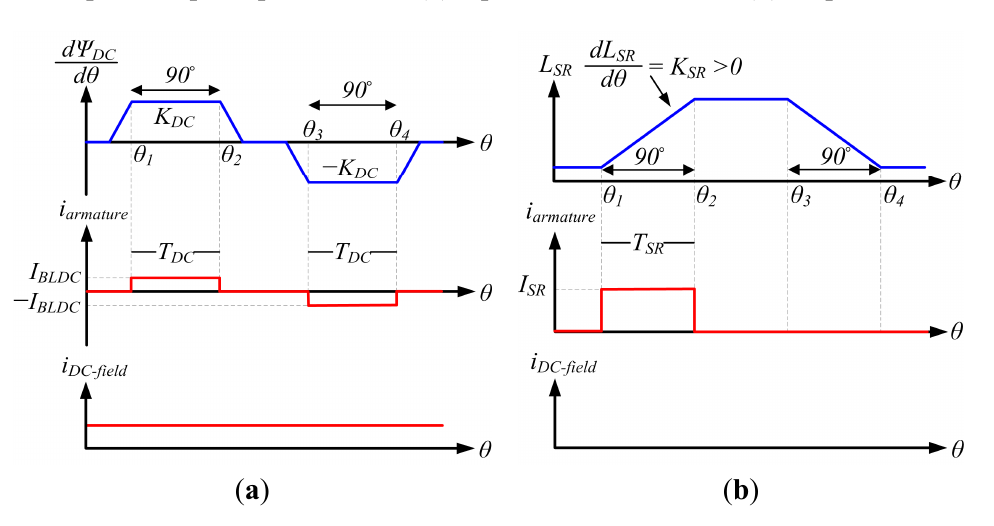
Figure 5. Operation principle schemes: ( a ) bipolar conduction; and ( b ) unipolar conduction.